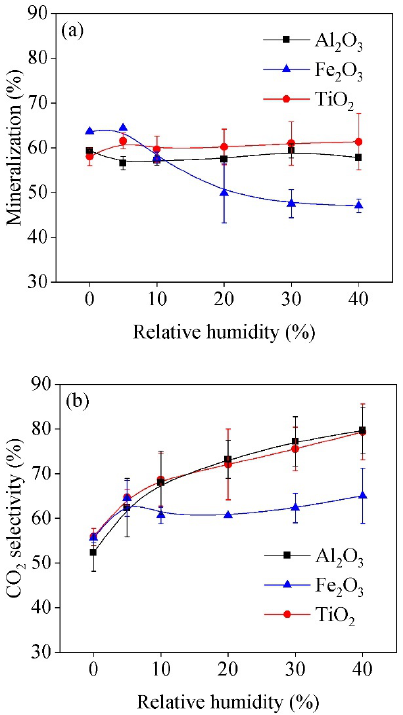
Figure 9. Effect of relative humidity on ( a ) the mineralization and ( b ) the CO 2 selectivity in the DBD reactor filled with Al 2 O 3 , Fe 2 O 3 , and TiO 2 . (Discharge power: 55 W; driving frequency: 12.6 kHz; initial naphthalene concentration: 28 ppm; total gas flow rate: 500 mL/min; discharge gap: 3